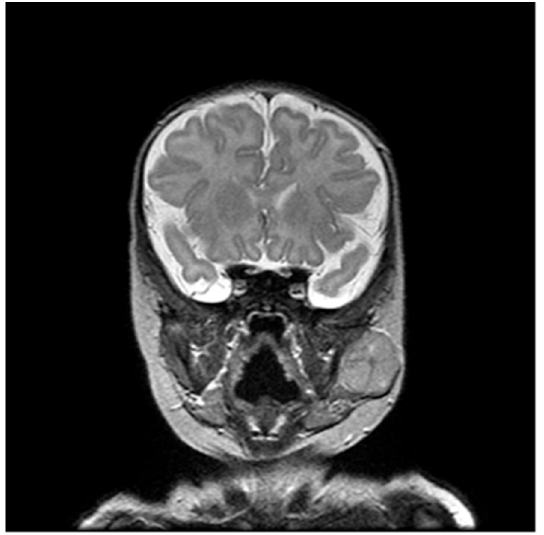
Figure 2. Coronal plane image of the tumor in T2 FSE (Fast Spin Echo) magnetic resonance imaging.